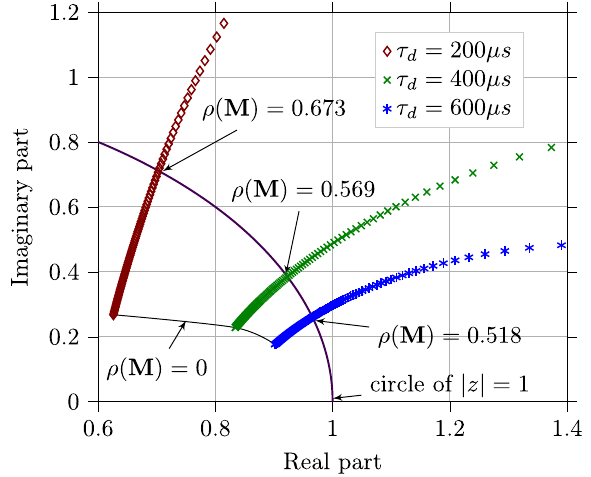
FIG. 15. The pole movement over the complex plane from inside to outside of the unit circle with the increase of ρ ð M Þ